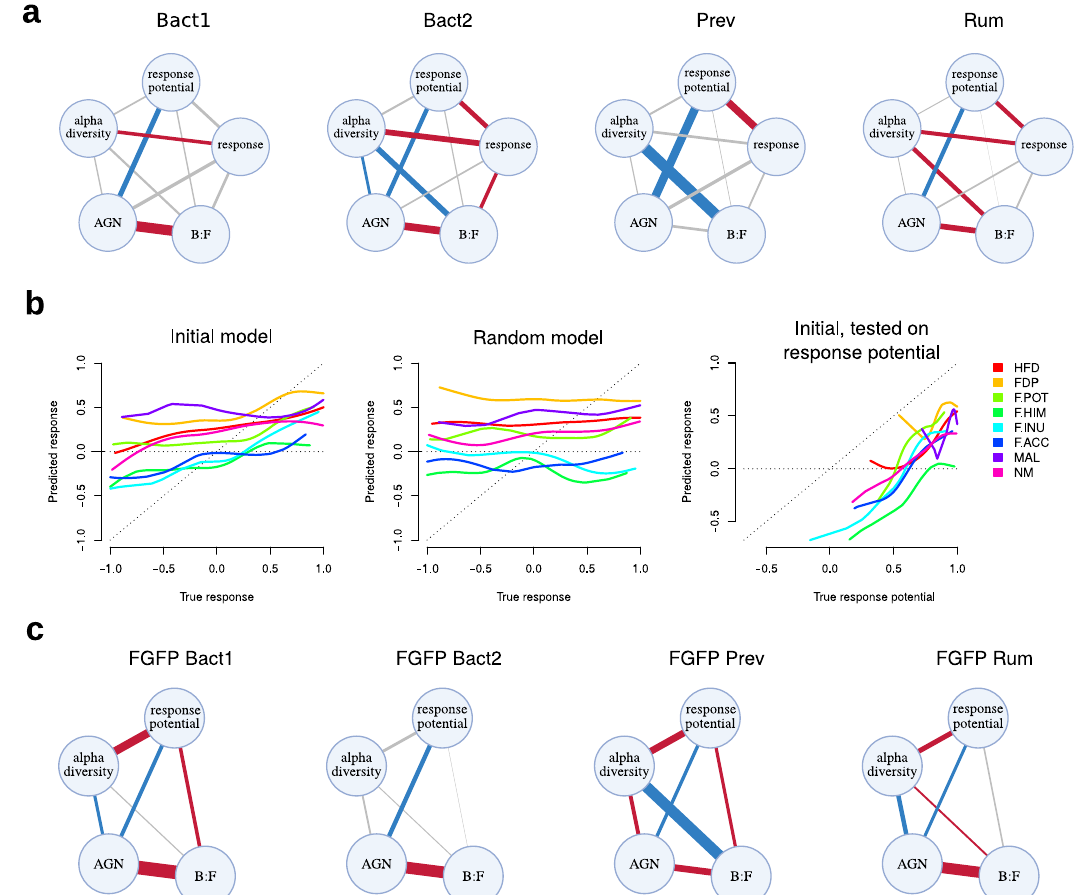
Fig. 4 Associations of microbiome response potential with the baseline microbiome composition features and response to the interventions. a Partial correlation networks between the response potential, response, baseline alpha diversity, AGN and B:F calculated in each enterotype. The edge's width is proportional to absolute correlation coef fi cient. Blue colour denotes signi fi cant negative associations, red - signi fi cant positive and white – insigni fi cant (signi fi cance estimated using partial correlations, FDR < 0.05). b Relation between predicted and true response (or response potential) for different interventions. Predicted response was calculated based on baseline species abundances using XGBoost machine learning algorithm. c Partial correlation networks between the response potential, baseline alpha diversity, AGN and B:F calculated in each enterotype on the FGFP